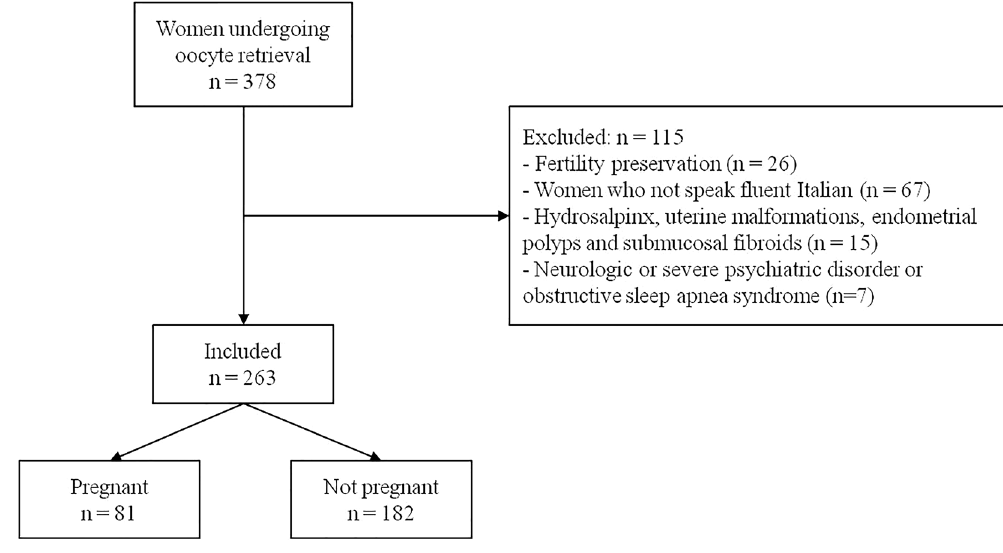
Figure 1. Flow-diagram of the